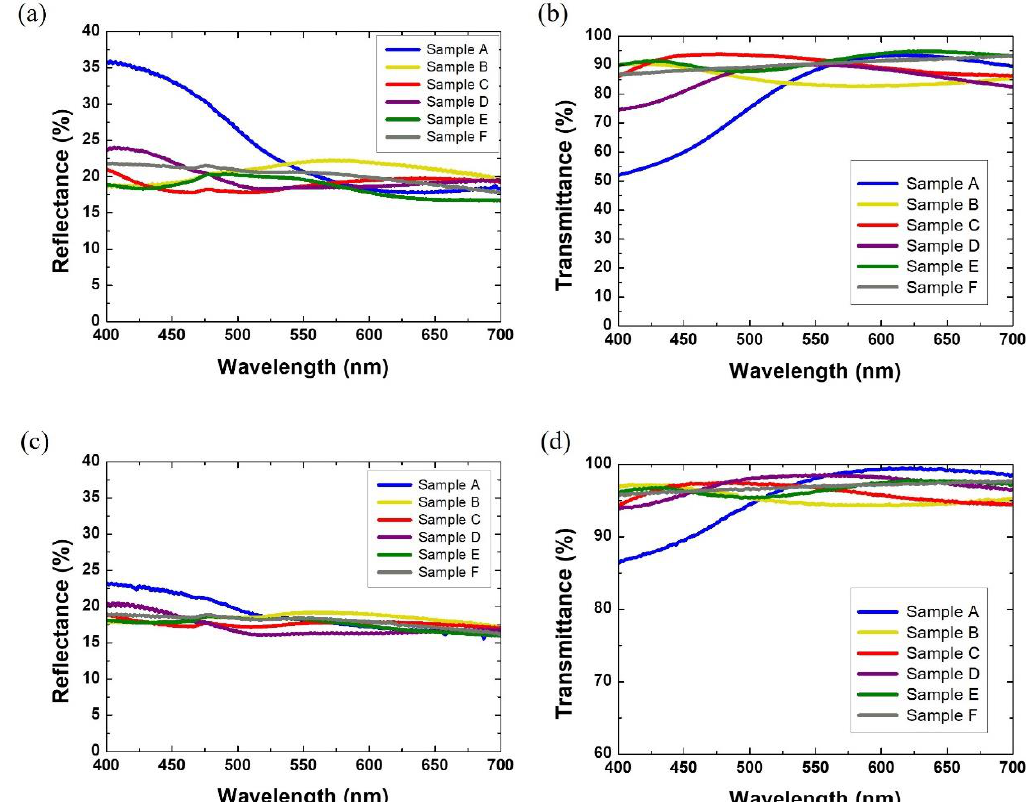
Figure 5. ( a ) Reflectance and ( b ) transmittance spectra of colored glass samples produced at a spin coating speed of 1000 rpm. ( c ) Reflectance and ( d ) transmittance spectra of colored glass samples produced at a spin coating speed of 3000 rpm: A (blue solid line), B (yellow solid line), C (red solid line), D (violet solid line), E (green solid line), F (grey solid line).